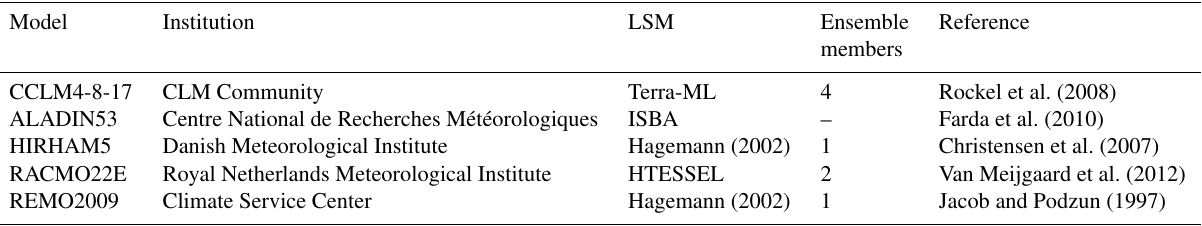
Table 2. EURO-CORDEX regional climate models providing ERA-Interim-driven runs for the snow water equivalent variable at 0.11 ◦ spatial resolution considered in this study. For each of model we also report the land-surface model (LSM), the number of available GCM-driven runs and the